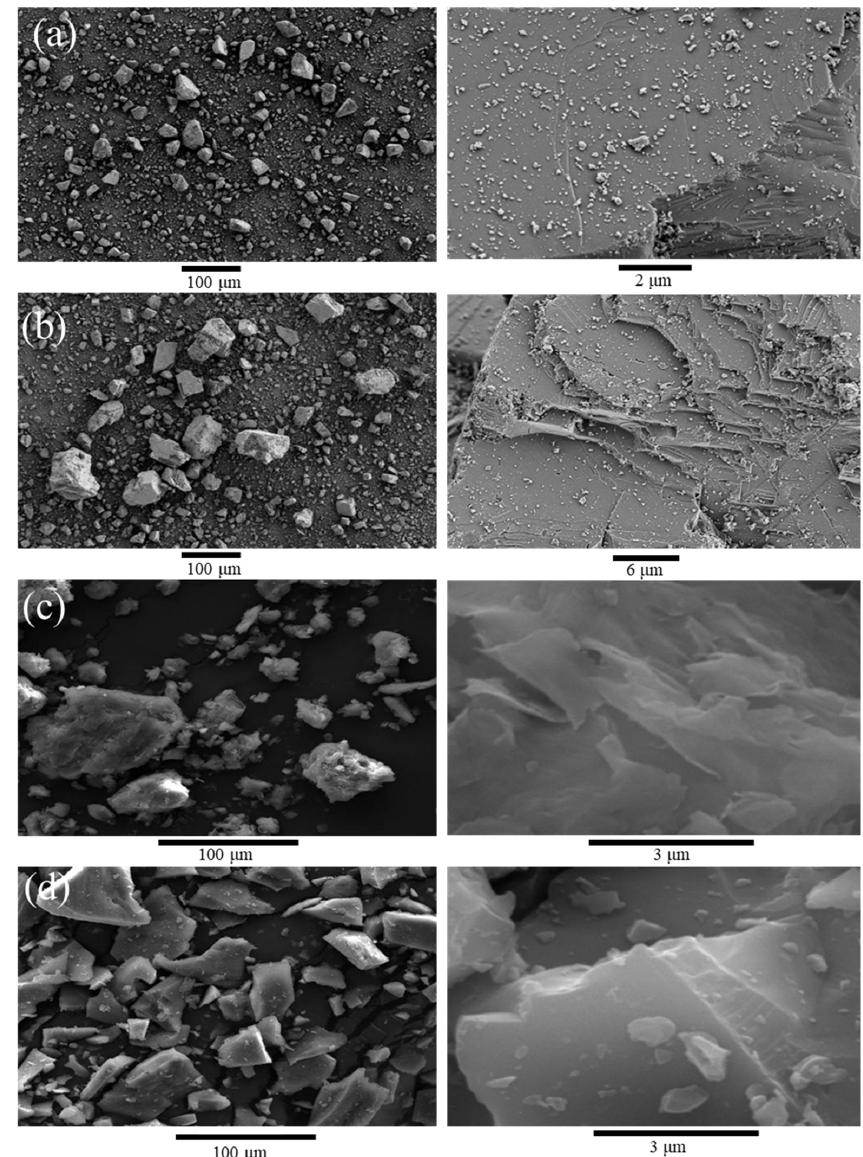
Figure 4. SEM images of ( a ) smithsonite, ( b ) calcite, ( c ) kaolinite, and ( d ) quartz.